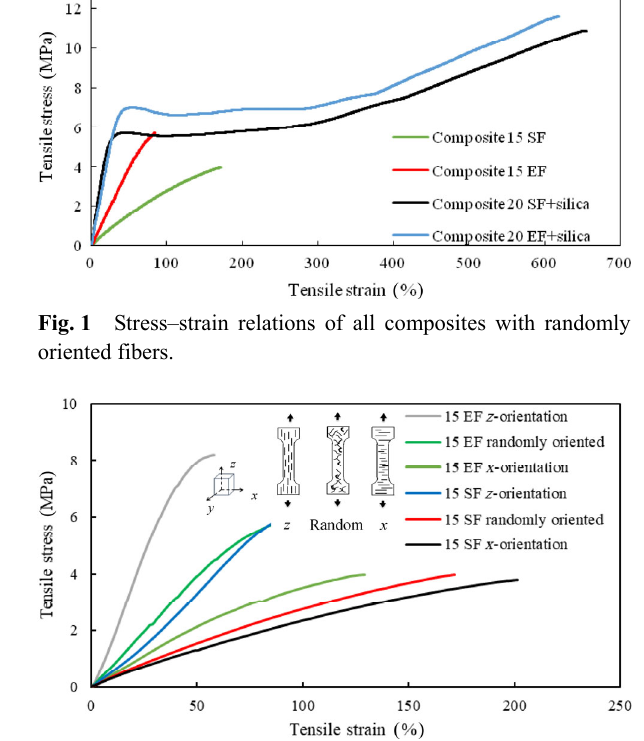
Fig. 2 Stress–strain relations of composites 15 SF and 15 EF for several reinforcement